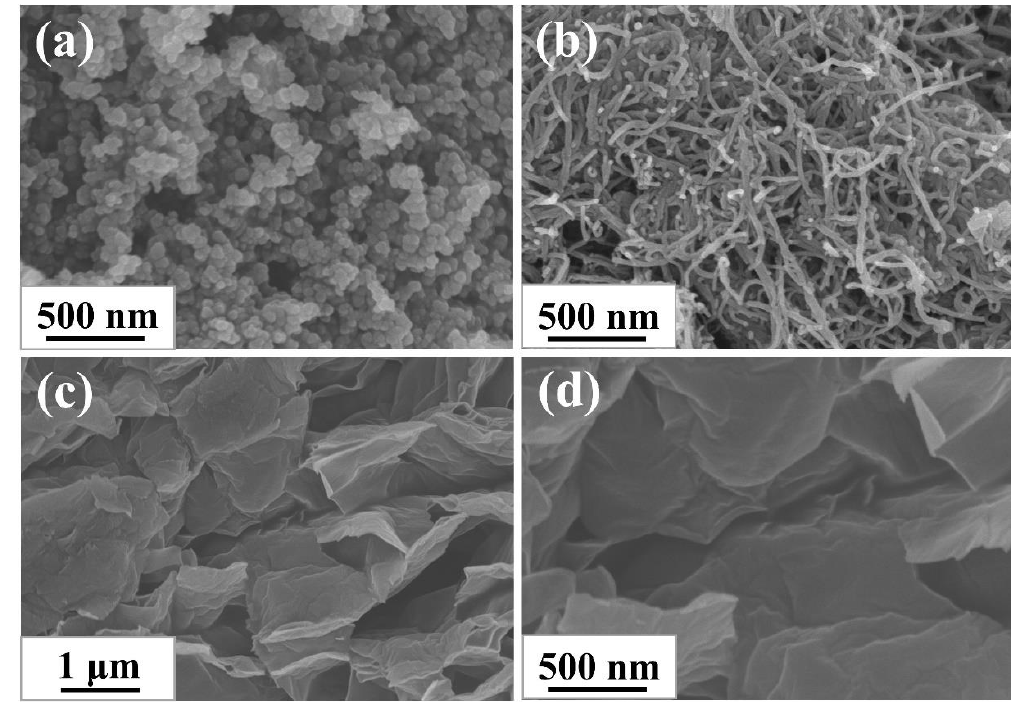
Figure 1. SEM images of ( a ) CB; ( b ) CNTs, and ( c , d ) GE.